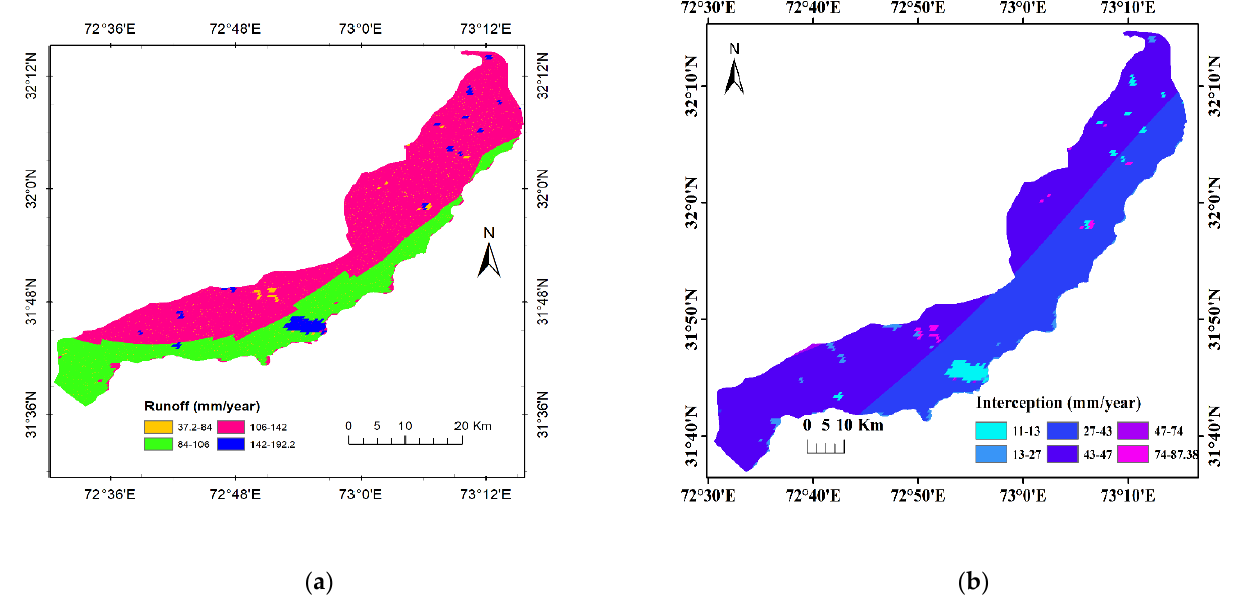
Figure 10. Long-term simulated distribution of average annual ( a ) runoff and ( b ) interception. Groundwater recharge is also a necessary component of groundwater management and was simulated for long-term (20 years) annual, seasonal, and monthly periods, as